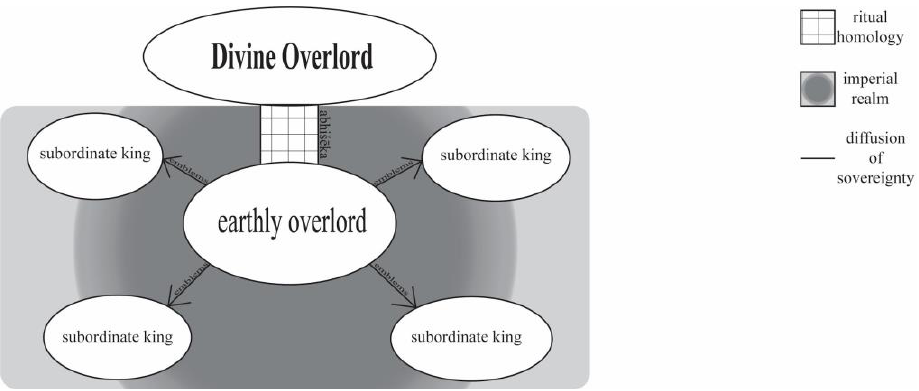
Figure 1. Model of the diffusion of authority and sovereignty based on Dirks, Inden, Kulke, and Stein 6 .